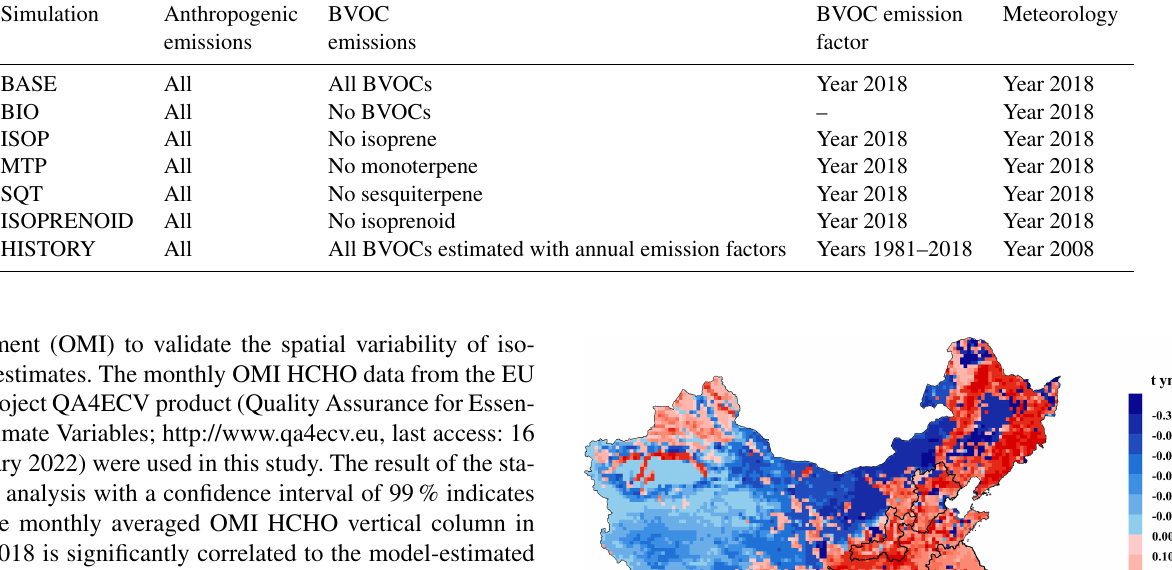
Table 1. Description of different model simulations in this study. Simulation